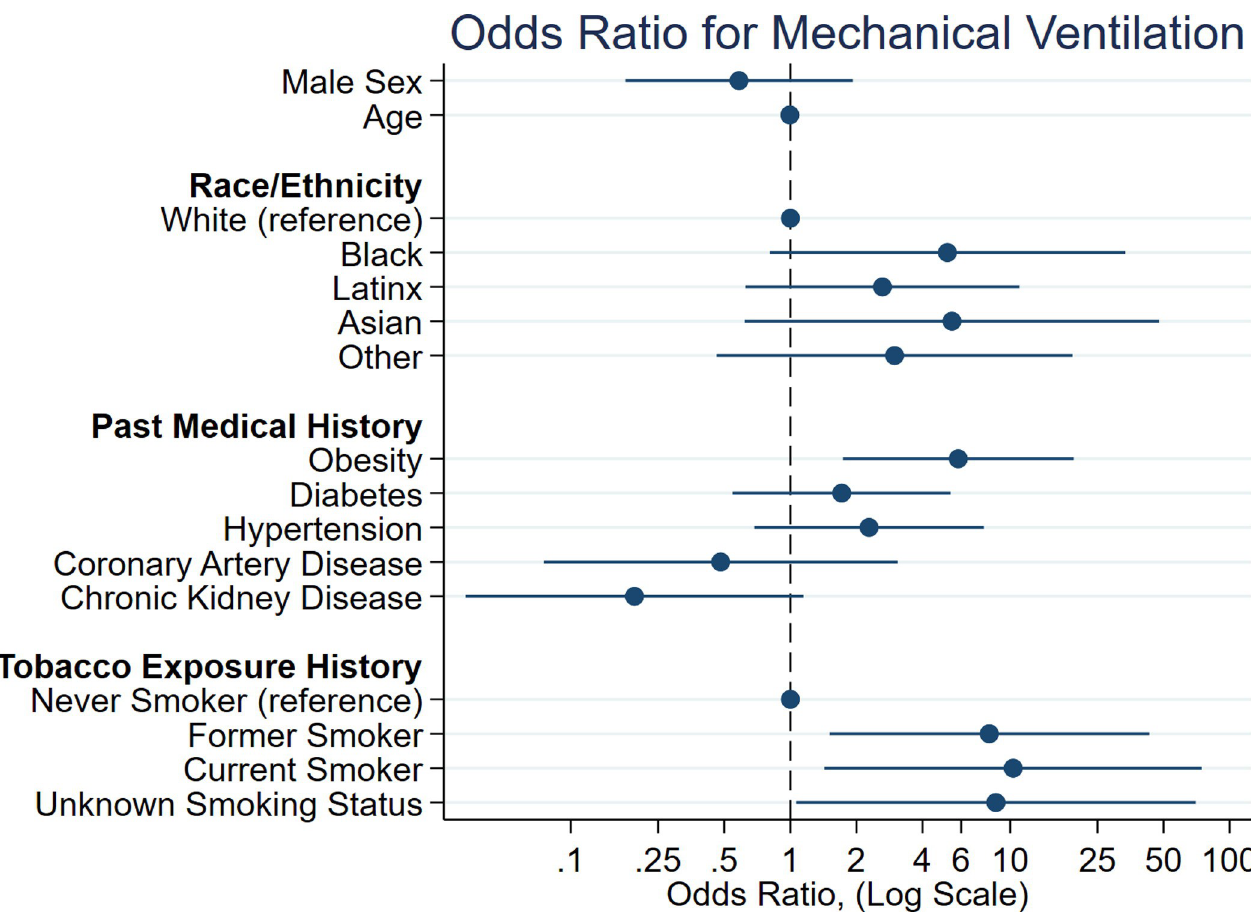
Fig 1. Forest plot of multivariable logistic regression analysis adjusting for age, sex, and comorbidities with cohort prevalence of � 15%. The x-axis is depicted on a log scale.